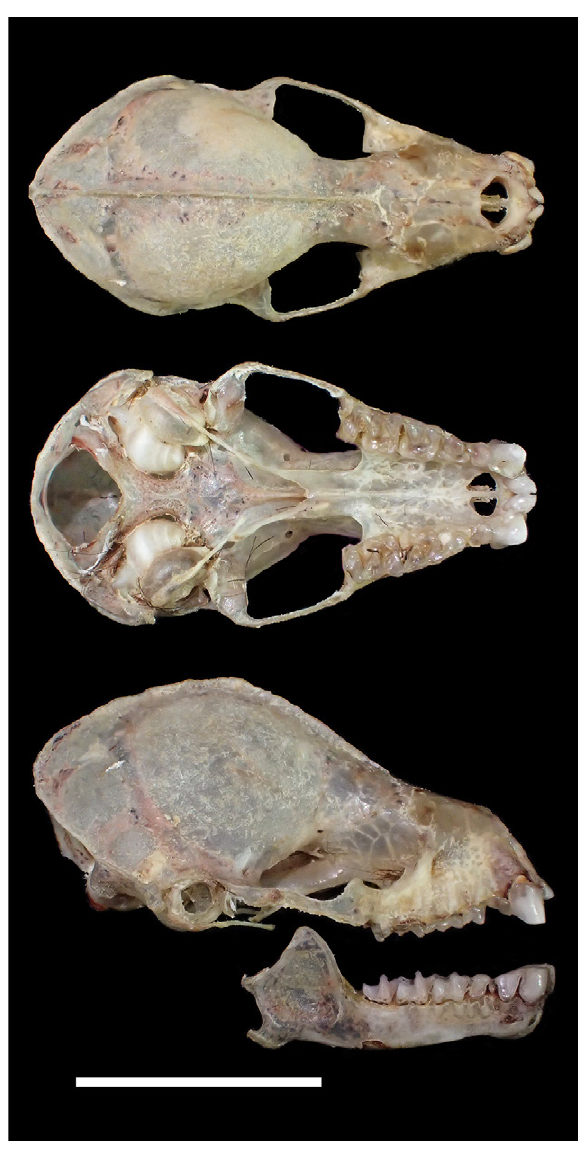
Figure 3. Dorsal, ventral, and lateral views of skull and lateral view of mandible of Lophostoma brasiliense (LMUSP 512) from Caiuá, São Paulo, Brazil. Scale bar = 10